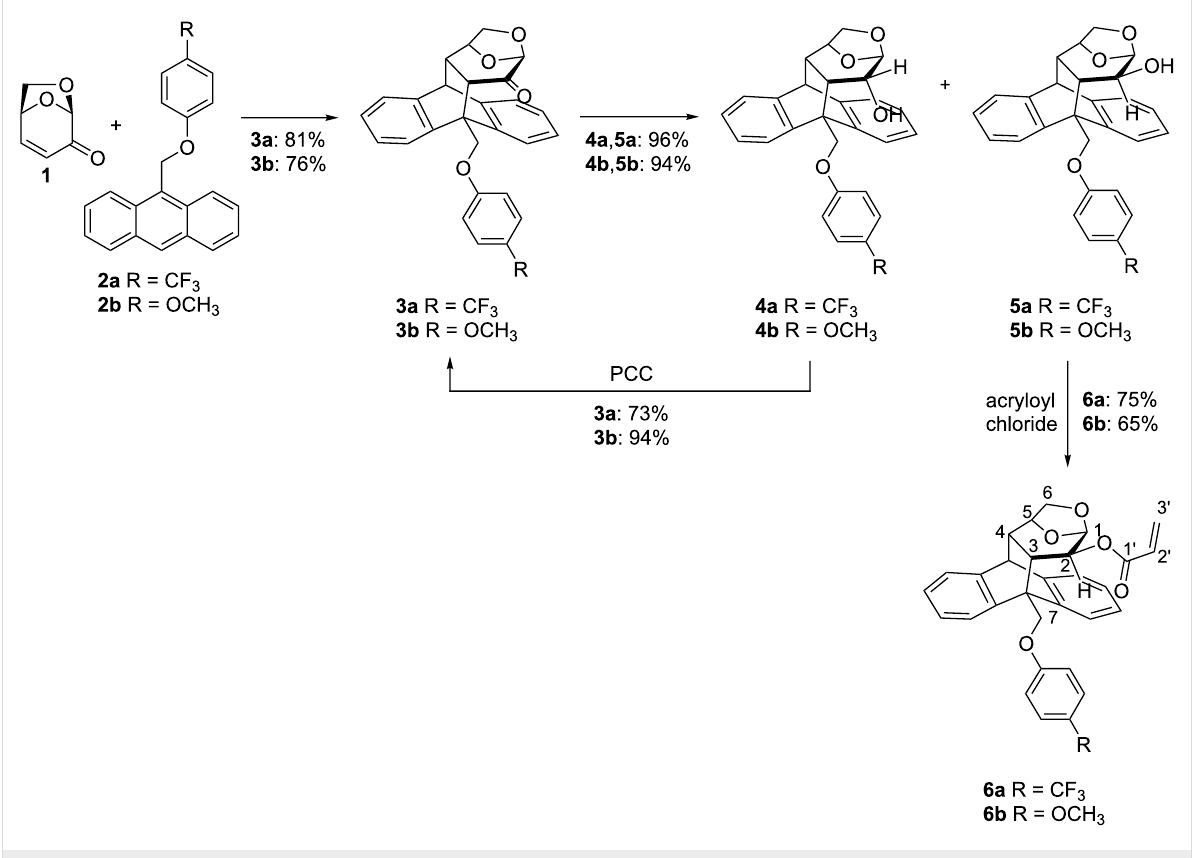
duction of electronically different substituents at the aromatic ring of the chiral auxiliary. For this reason, we planned to synthesize the acrylic esters, structurally related to the previ- ously reported acrylate, with CF 3 and OMe groups in the para position of the phenoxy group as representative electron-with- drawing and releasing groups, respectively. The π – π interaction was studied by combining experimental, spectroscopic and computational evidence of the structurally related chiral acry- lates to get new insights into the alkene–arene intramolecular interaction. Besides, it was evaluated the effect of the